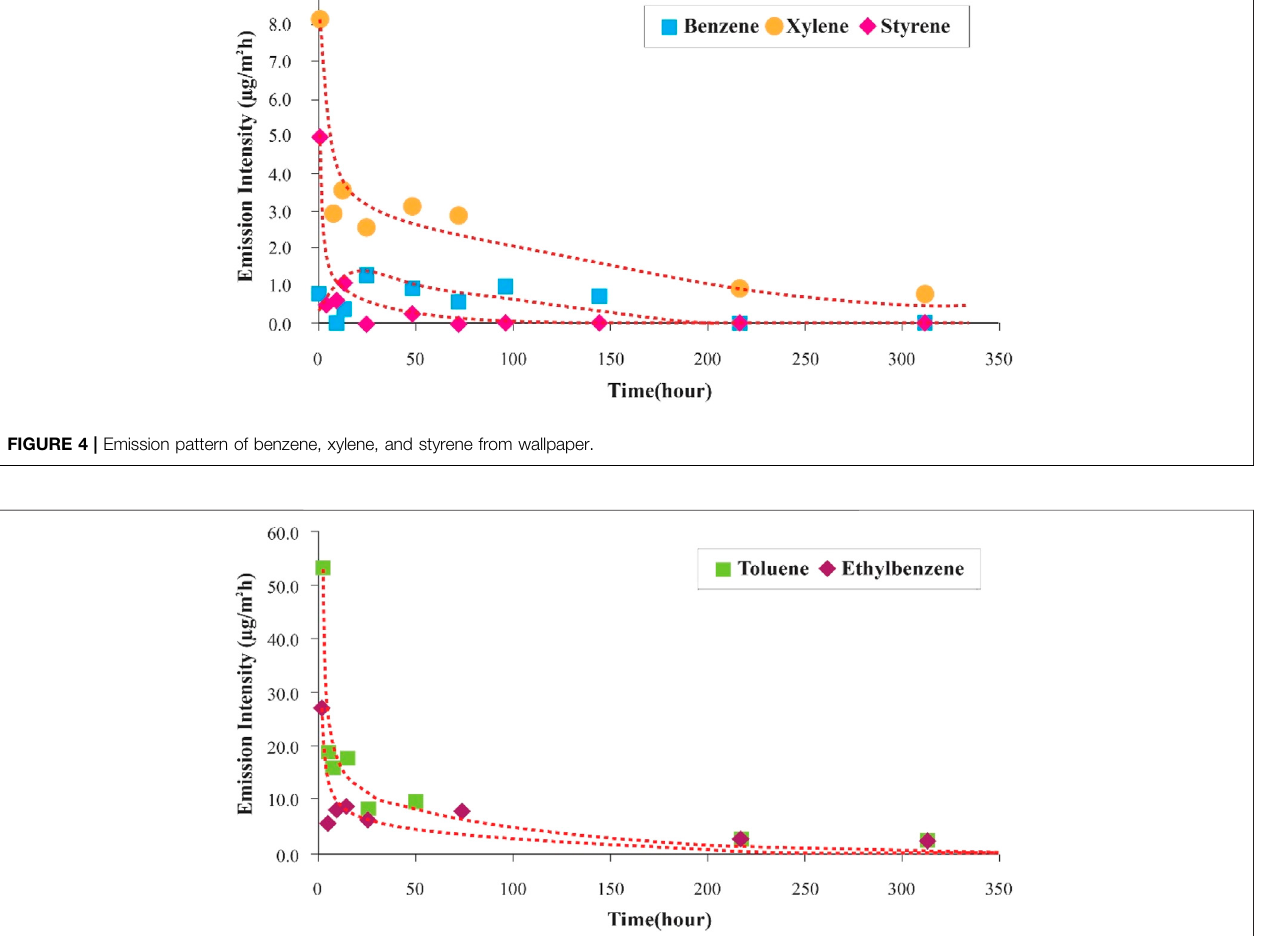
Frontiers in Built Environment |